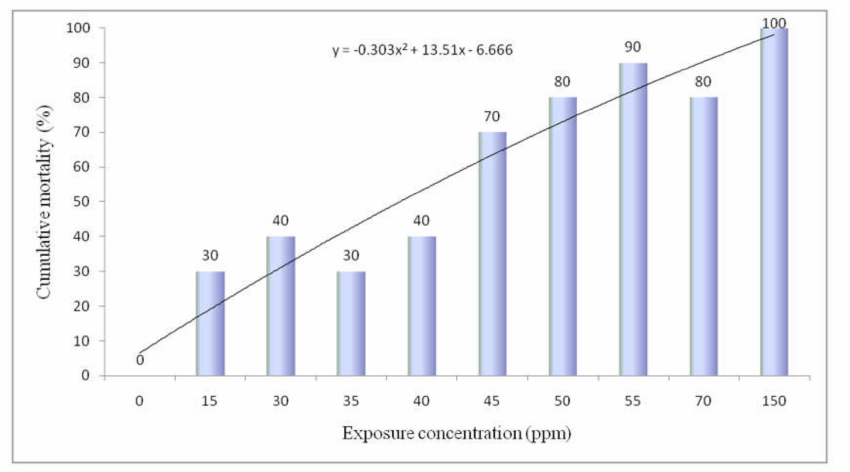
Figure 2. Cumulative mortality of rohu carp exposed to sodium arsenite for a period of 96 h.